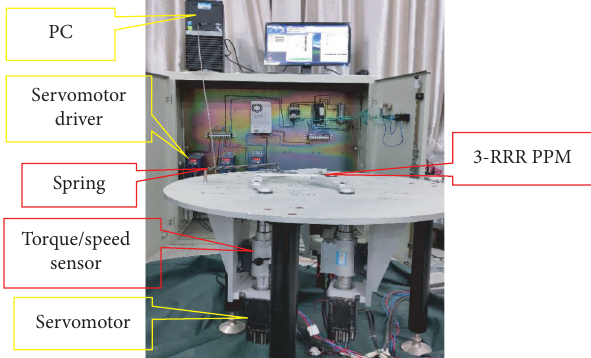
Figure 5: Convergence figure of the IBOA, BOA, and PSO.